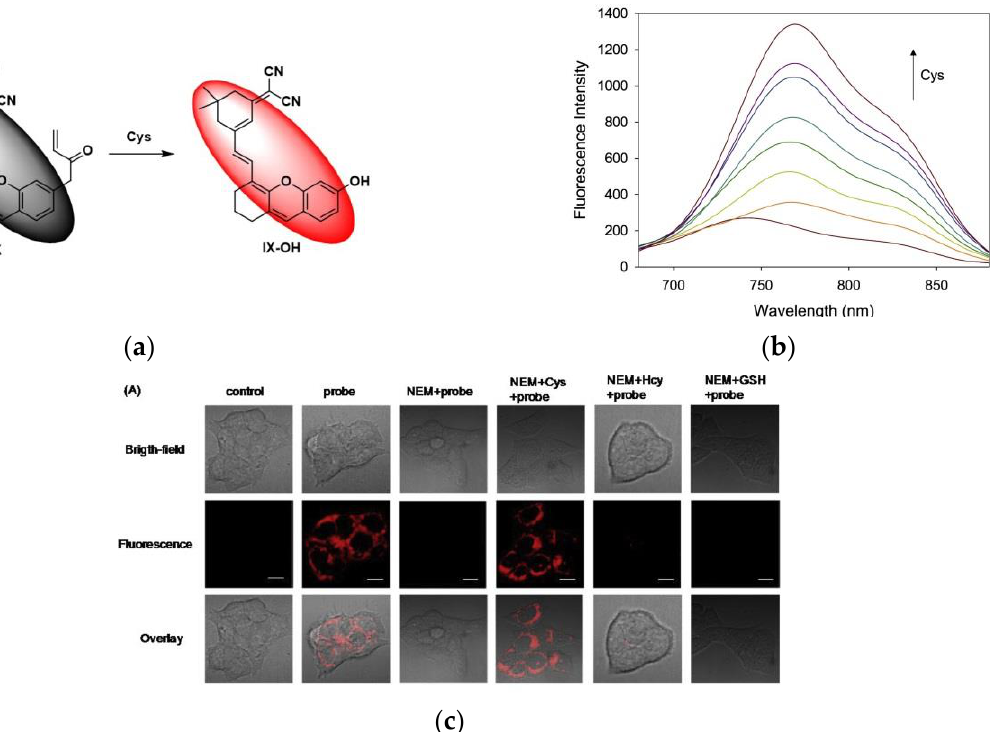
Figure 25. ( a ) Mechanism of the IX activation by Cys; ( b ) Fluorescence spectra of IX; ( c ) Fluorescence imaging of biothiols in HCT116 cells. Reproduced with permission from [106]. Copyright 2021 Elsevier B.V.